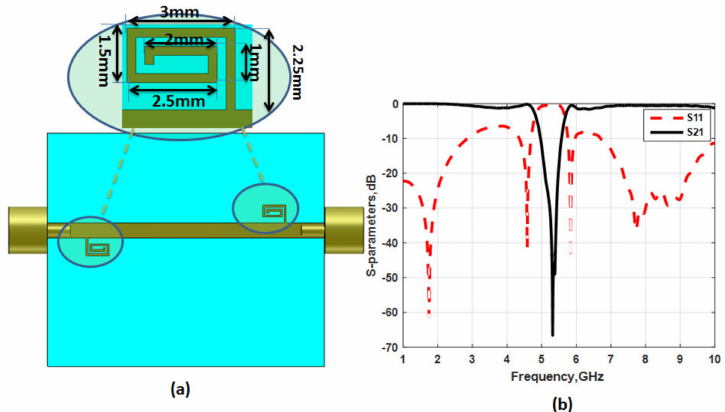
Figure 11. Microstrip line loaded with spiral resonator band stop filter. ( a ) 2-D layout ( b ) S-parameters simulated